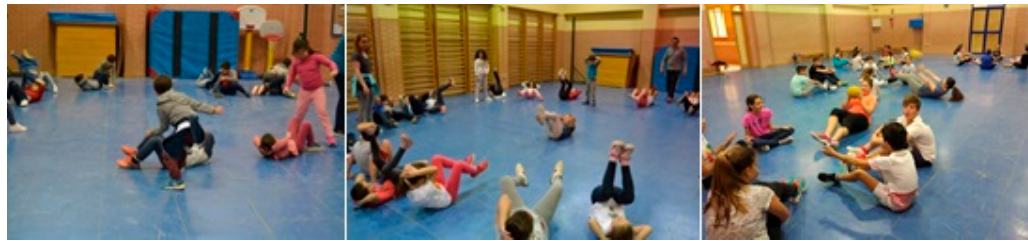
Figure 1. Implementation of safe fall program in primary school.